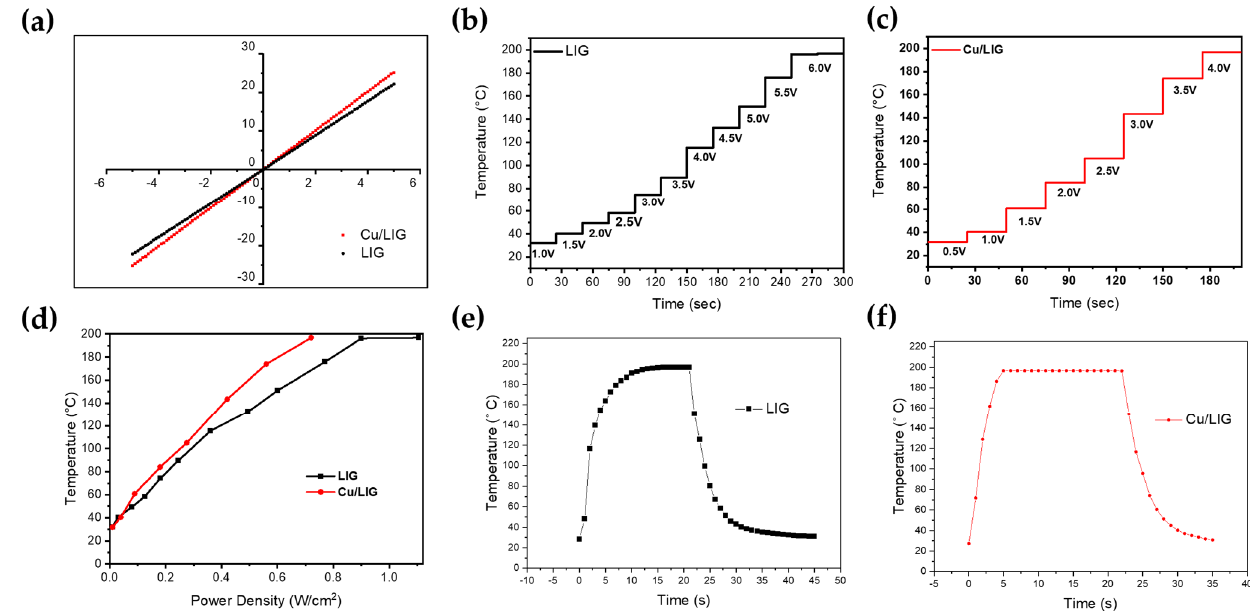
Figure 6. ( a , b ) I–V curve measurement of LIG and Cu/LIG. ( b , c ) Temperature evolution of LIG and Cu/LIG at stepwise voltage rise from 1 to 6 V. ( d ) Temperature as a function of the applied electrical power density for LIG and Cu/LIG. ( e , f ) Heating and cooling time for LIG and Cu/LIG. Aircraft icing refers to the formation of ice on the surface of an aircraft due to cloud particles or supercooled water droplets below the freezing point temperature [50].